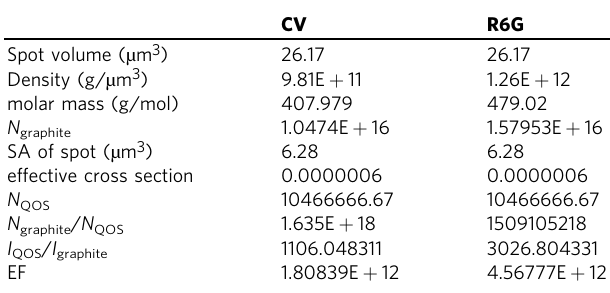
Table 1 Detailed calculation values of enhancement